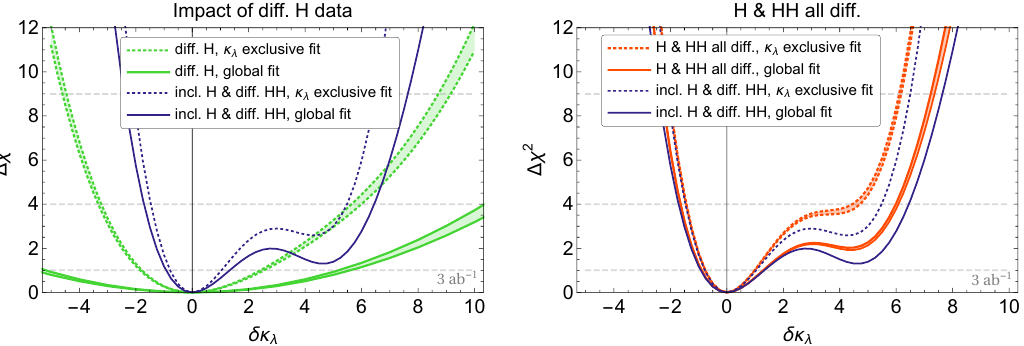
Figure 5 . Left: (cid:31) 2 as a function of the Higgs trilinear self-coupling. The green bands are obtained from the di(cid:11)erential analysis on single-Higgs observables and are delimited by the (cid:12)ts corresponding to the optimistic and pessimistic estimates of the experimental uncertainties. The dotted green curves correspond to a (cid:12)t performed exclusively on (cid:14)(cid:20) (cid:21) setting to zero all the other parameters, while the solid green lines are obtained by a global (cid:12)t pro(cid:12)ling over the single-Higgs coupling parameters. Right: the red lines show the (cid:12)ts obtained by a combination of single-Higgs and double- Higgs di(cid:11)erential observables. In both panels the dark blue curves are obtained by considering only double-Higgs di(cid:11)erential observables and coincide with the results shown in (cid:12)gure 4. which is signi(cid:12)cantly smaller than the one obtained through a global (cid:12)t, as can be seen by comparing with the solid lines in (cid:12)gure